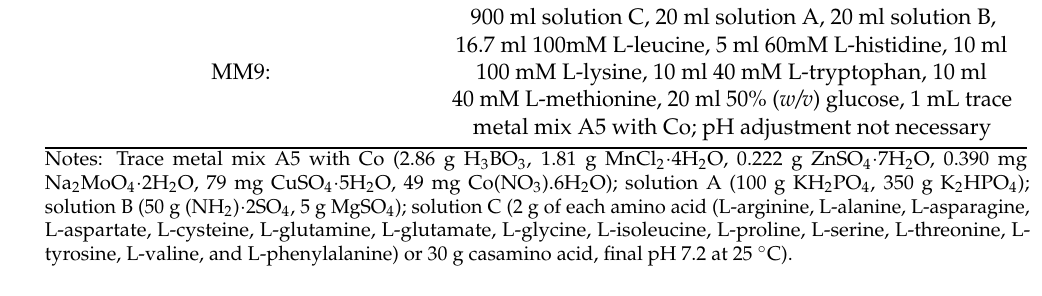
Table 1. Cont. Cultivation Media